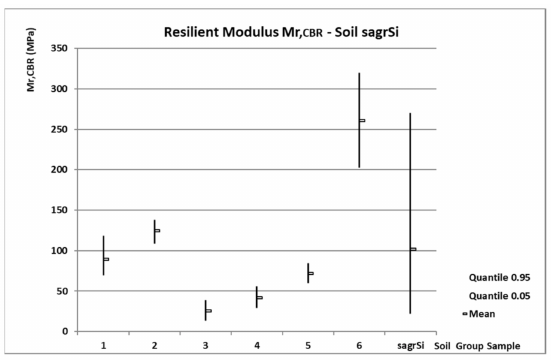
Figure 5. Statistical quantities—mean, 0.05 quantile, 0.95 quantile of M r,CBR for sagrSi